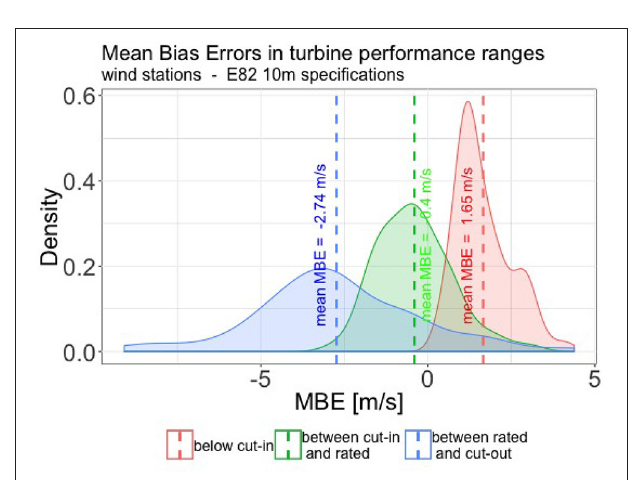
FIGURE 11 | MBE for turbine performance